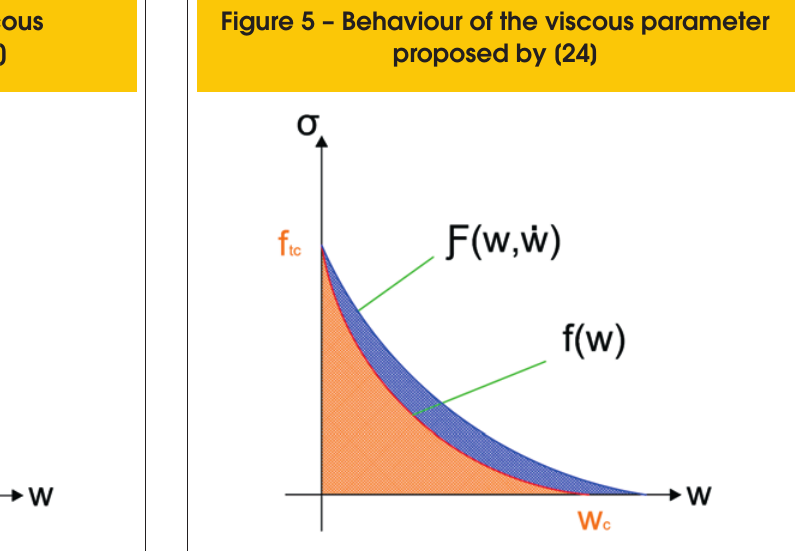
Figure 4 – Behaviour of the viscous parameter proposed by [23]